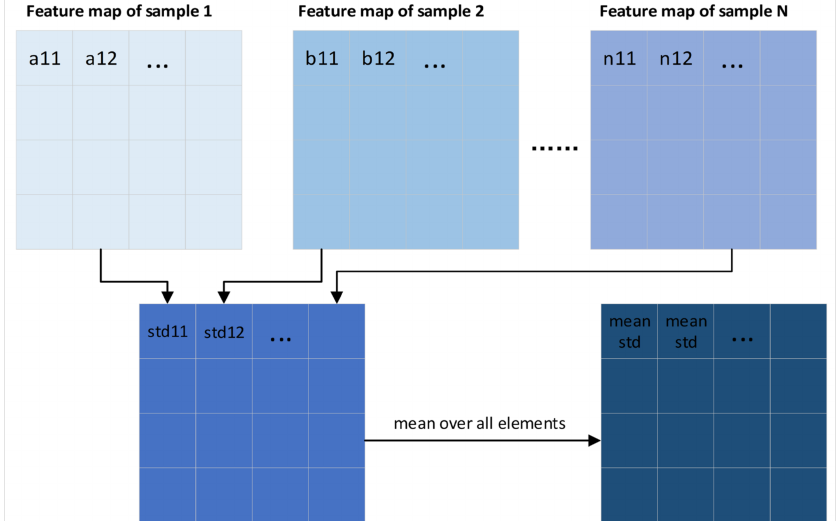
Figure 5. The minibatch standard deviation flow chart. Feature map1, 2 . . . N is divided equally into multiple parts and finds the standard deviation of each image’s feature map at different spatial locations. This results in a new feature map, which is then averaged over the feature map to obtain a value, and this value is expanded to the size of a feature